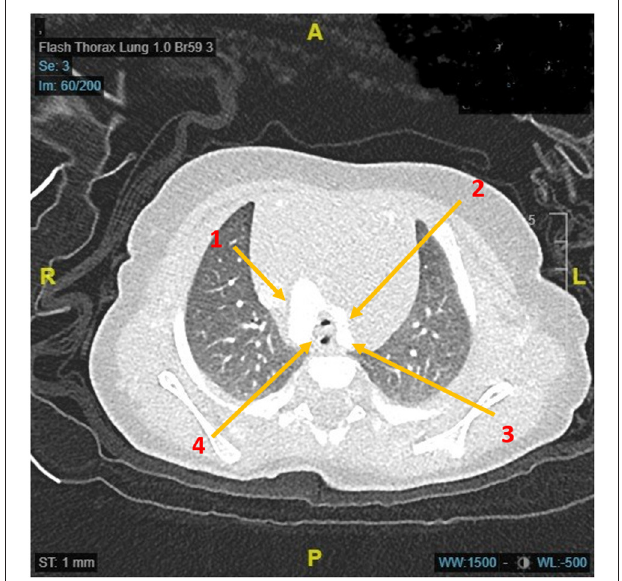
FIGURE 2 | Axial computerized tomographic image demonstrating the double aortic arch and a very small tracheal lumen due to acute angulation between two anterior arches. Arrow 1: Right aortic arch; Arrow 2: Left aortic arch; Arrow 3: Origin of left subclavian artery; Arrow 4: Narrow trachea and esophagus in the vascular ring complex indicating narrow anterior